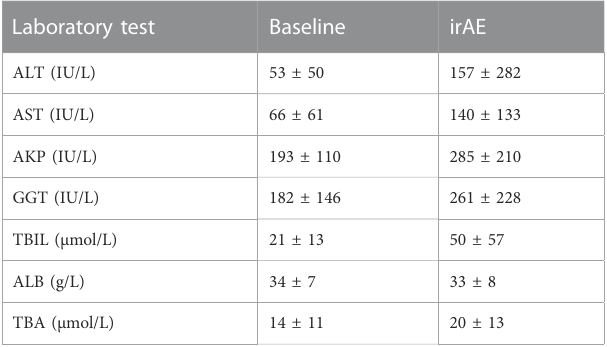
TABLE 3 Laboratory test with hepatic irAE